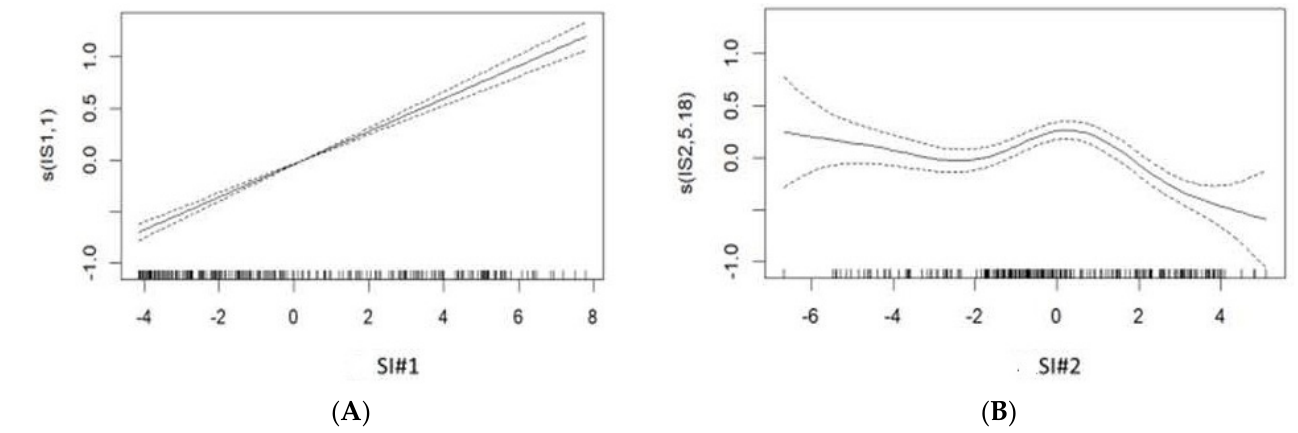
Figure 3. Generalized additive model of synthetic indicators #1 ( A ) and #2 ( B ). The solid line represents the relationship between synthetic indicators #1 or #2 and malaria incidence, and the dotted line represents the 95% confidence interval.